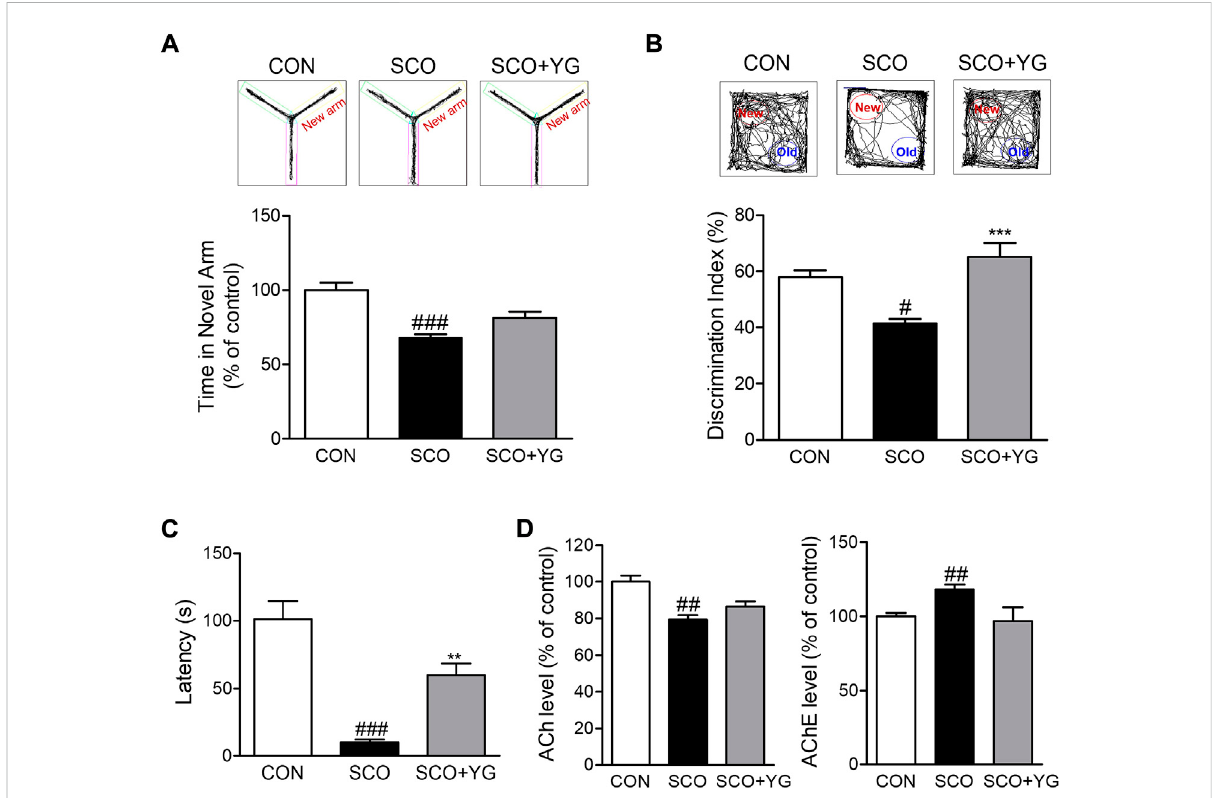
FIGURE 5 Effect of YG on memory impairment and acetylcholinergic signaling in scopolamine-induced mice. Behavior test in (A) Y-maze, (B) NORT and (C) PAT and (D) AChandAChElevel inthehippocampustissue ofmice. Alldataarepresentedas themean ±SEMfrommore thanthree independent